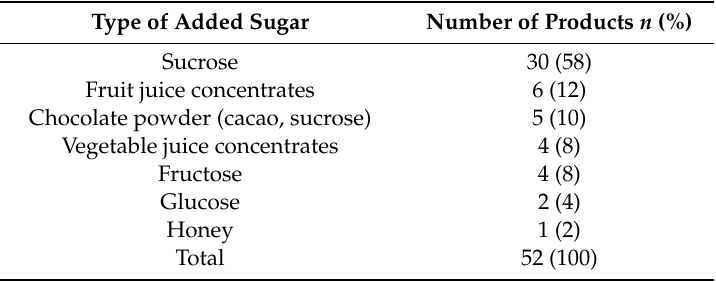
Table 2. Number of sweetened cereals by type of added sugar as reported on food labels.